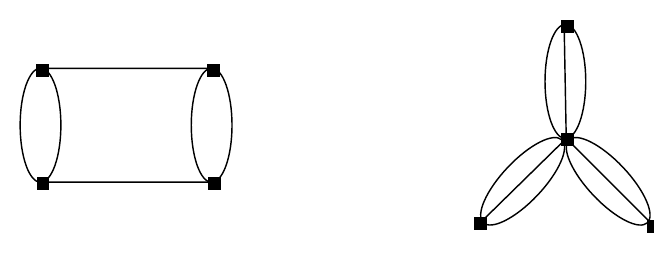
Figure 20 . Two different diagrams contributing to four traces with odd degree. Note that addi- tionally there is a diagram looking like a tetrahedron, contributing at the same order as the diagram shown on the